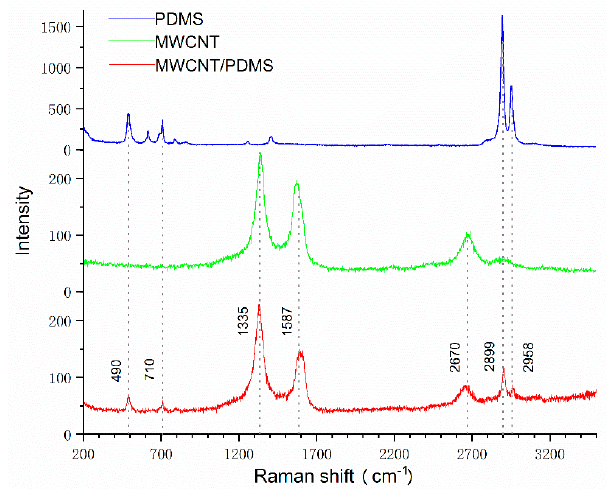
Figure 4. Raman spectra of the PDMS, MWCNTs, and the MWCNT/PDMS composite sheet.